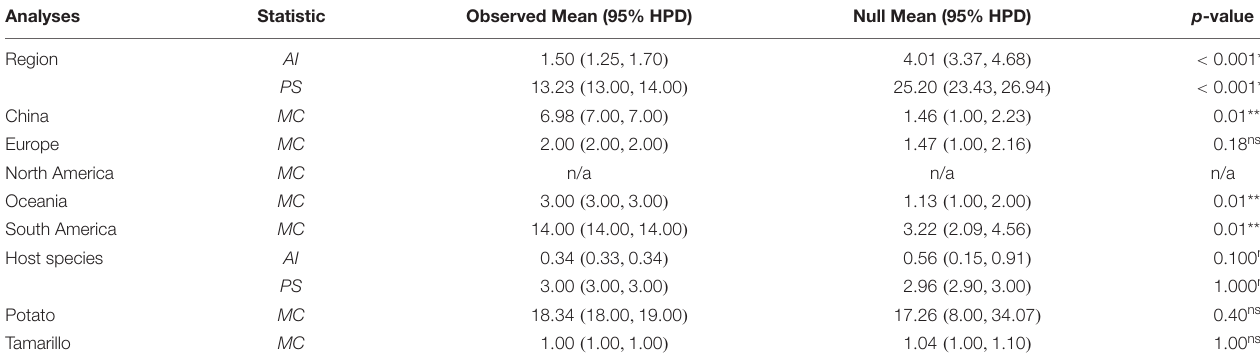
TABLE 6 | Analysis of the geographic and host effects on the population structure of PVA.